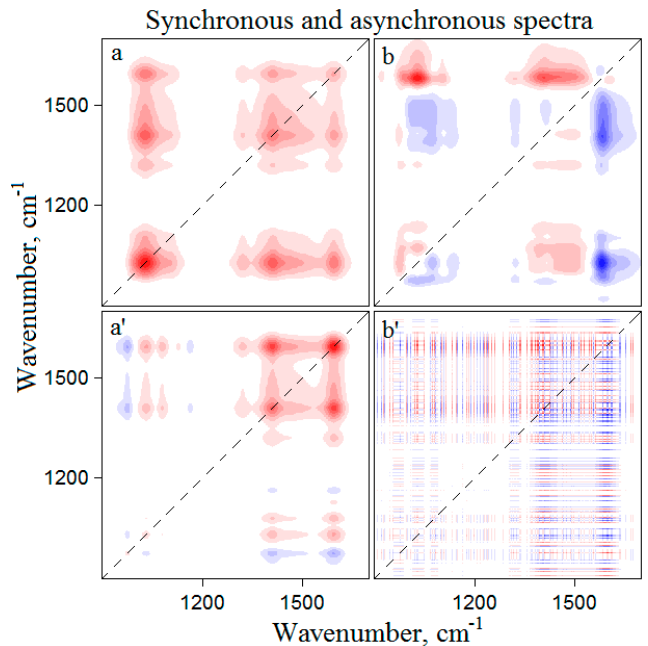
Figure 6. Experimental ( a ) synchronous and ( b ) asynchronous spectra and theoretical ( a’ ) synchronous and ( b’ ) asynchronous spectra in the 1750–870 cm − 1 region. For the experimental spectra, the synchronous spectrum (Figure 5a) present three auto-peaks at 3368, 2921, and 2878 cm − 1 . All the cross-peaks formed have positive values, indicating that all the bands vary in the same direction. The asynchronous spectrum (Figure 5b) shows clear peaks,